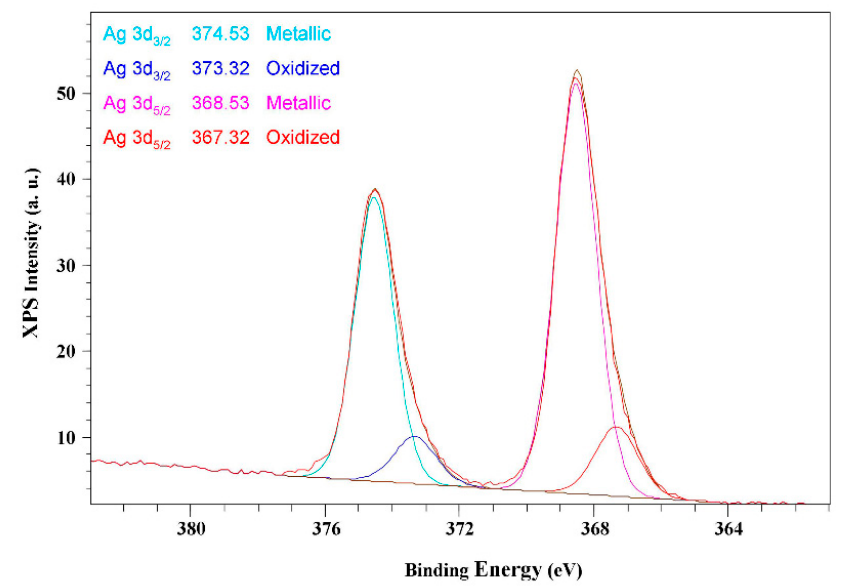
Figure 3. X-ray photoelectron spectrum of AgNPs. The binding energies are referred to as Ag 3d 3/2 and Ag 3d 5/2 in metallic and oxidized states .